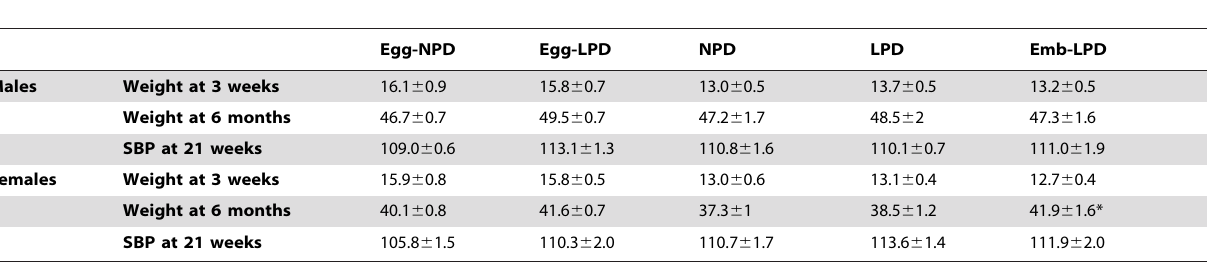
Table 2. Comparison of body weight and systolic blood pressure (SBP) measurements from mice analysed within the present